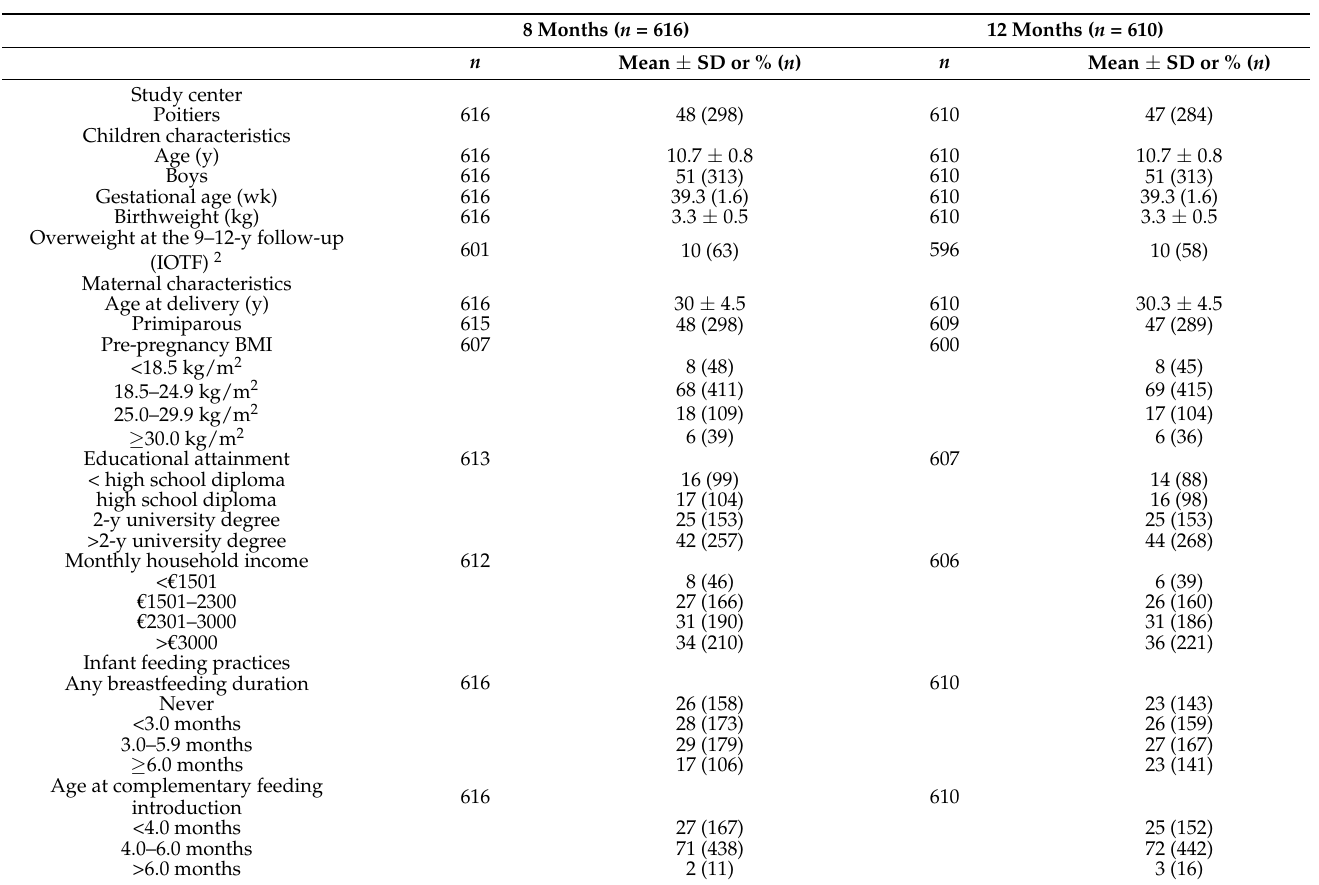
Table 1. Sample characteristics 1